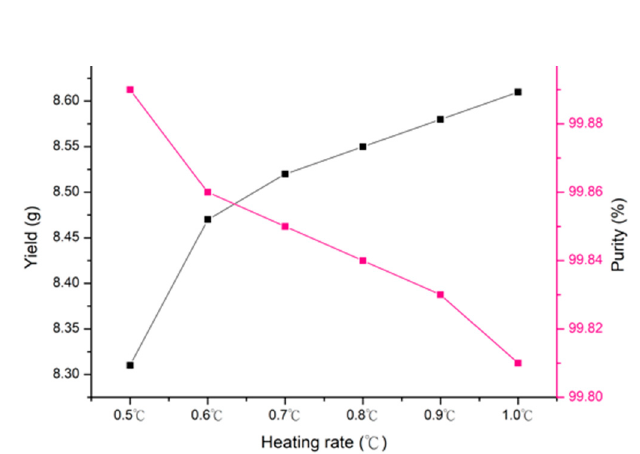
Figure 9. The yields and purities of the heating rate with